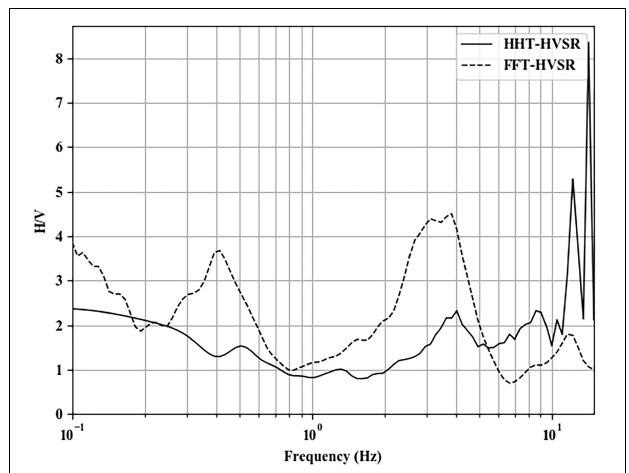
FIGURE 8 | HVSR curve at Station MM099. The solid line represents the HHT-HVSR curve after the removal of local noises, and the dashed line represents the FFT-HVSR